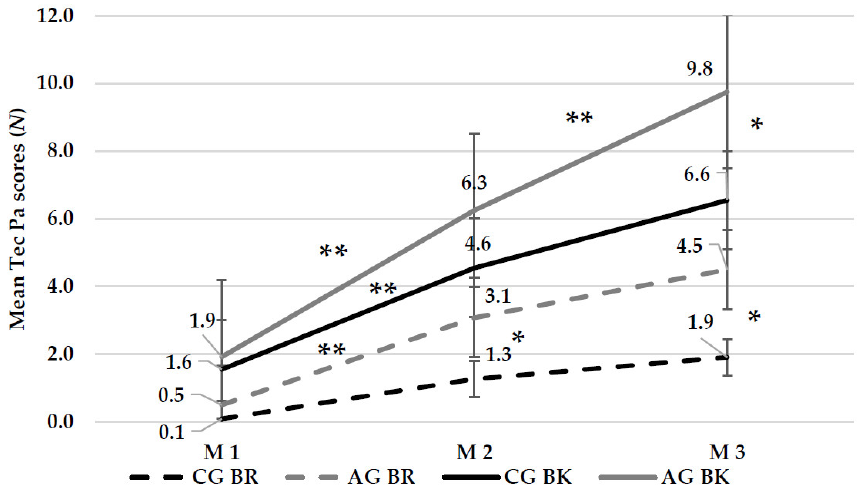
Figure 3. Swimmers’ mean score in Backstroke and Breaststroke. M 1 = Measurement 1, M 2 = Measurement 2, M 3 = Measurement 3, CG = Control Group, AG = Alternative Group, BR = Breaststroke, BK = Backstroke, * = Statistically significant difference between groups, ** = Statistically significant difference between measurements in each group.